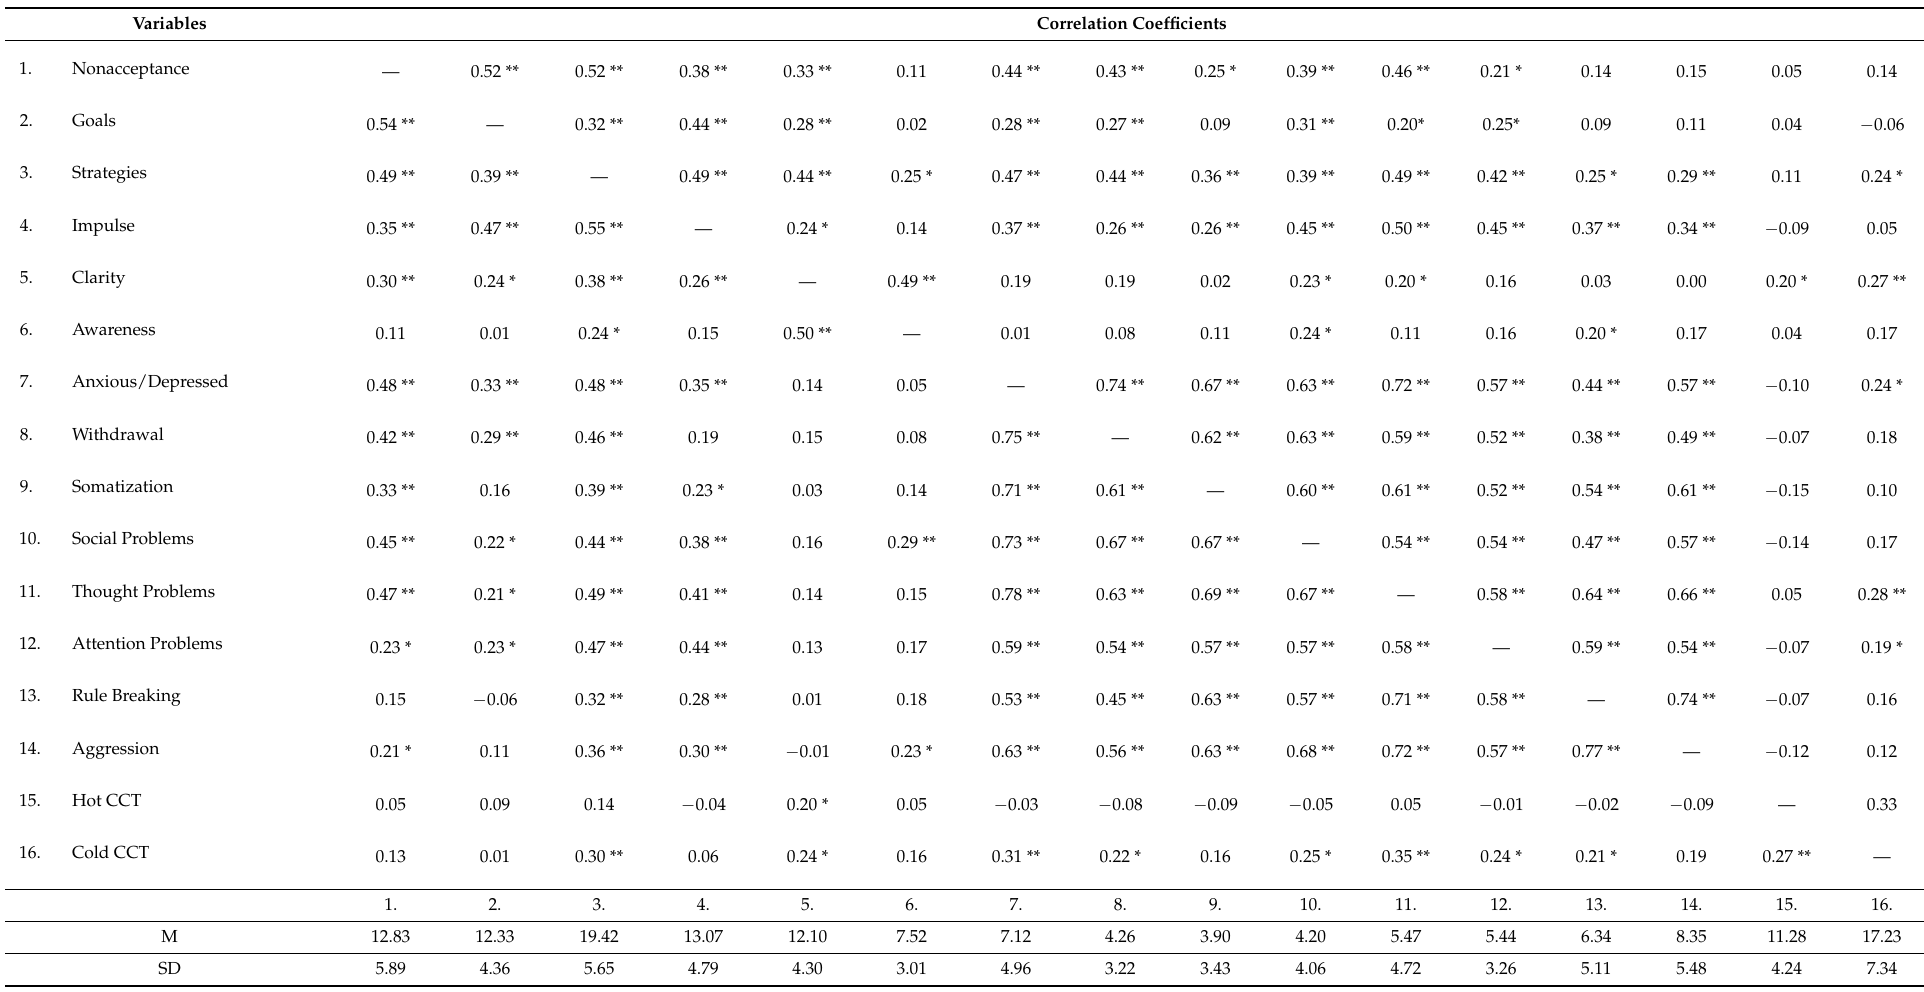
Table 1. Intercorrelations among six subscales of the Difficulties in Emotion Regulation Strategies, eight syndrome scales of the Youth Self-Report, and two decision-making